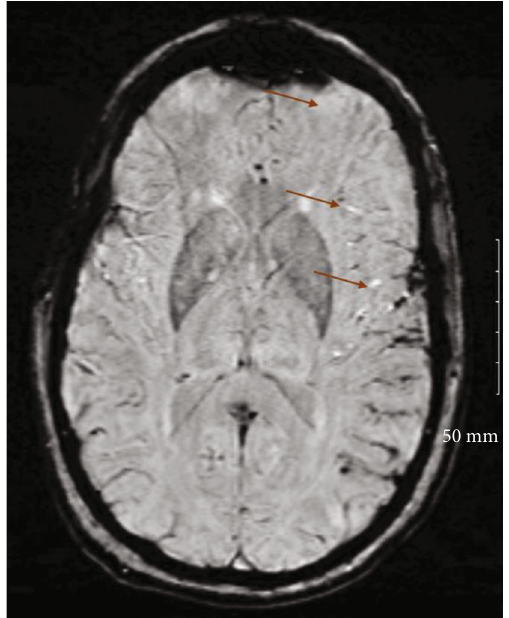
Figure 1: Susceptibility weighted magnetic resonance imaging showing the multifocal left frontal and parietal cortical